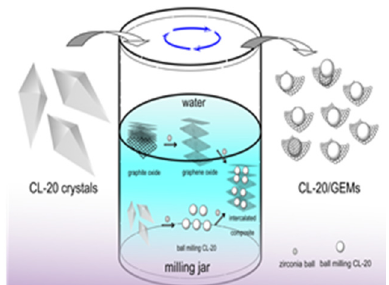
Figure 2. Schematic diagram of the formation of CL-20/graphene composite material. Reprinted Figure 3. Schematic diagram of the formation of CL-20/graphene composite material. from ref. [23].